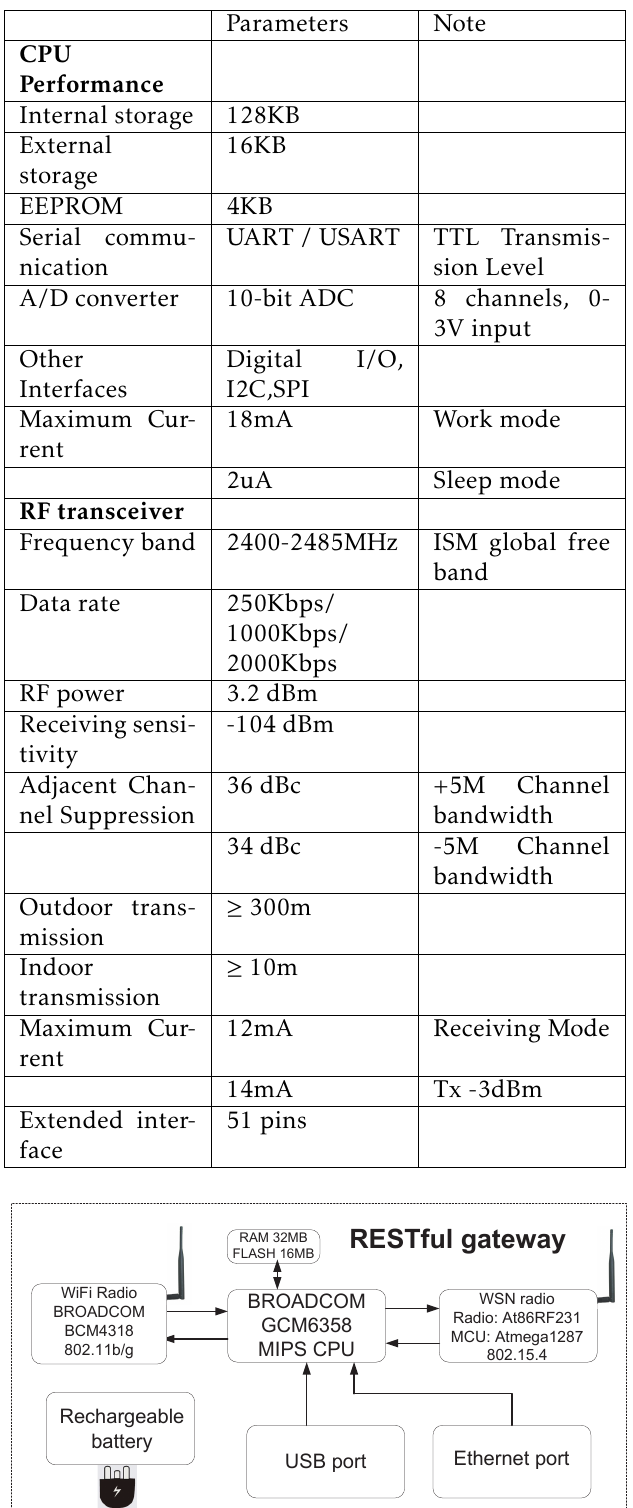
Table 3. Technical specifications of gateway